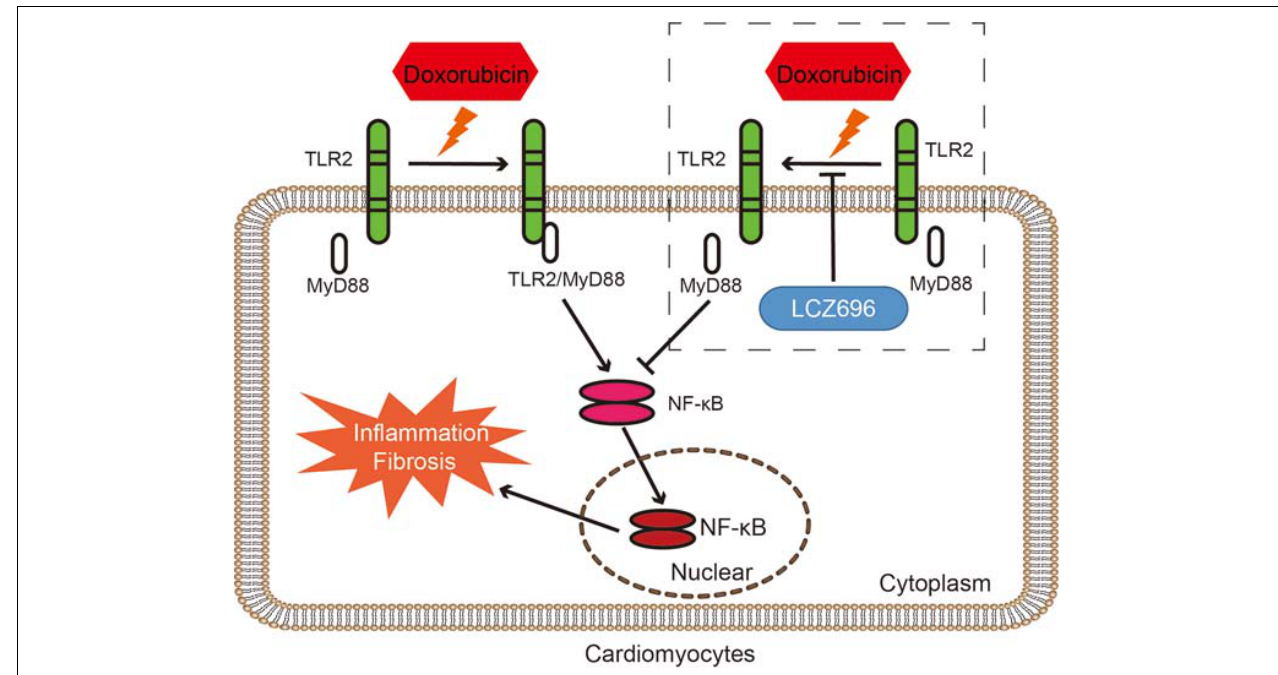
FIGURE 7 | LCZ696 attenuated doxorubicin-induced heart injury through the TLR2-MyD88 pathway. The mechanism by which LCZ696 relieves DOX-induced cardiac inflammation, fibrosis and heart failure lies in reducing the formation of TLR2-MyD88